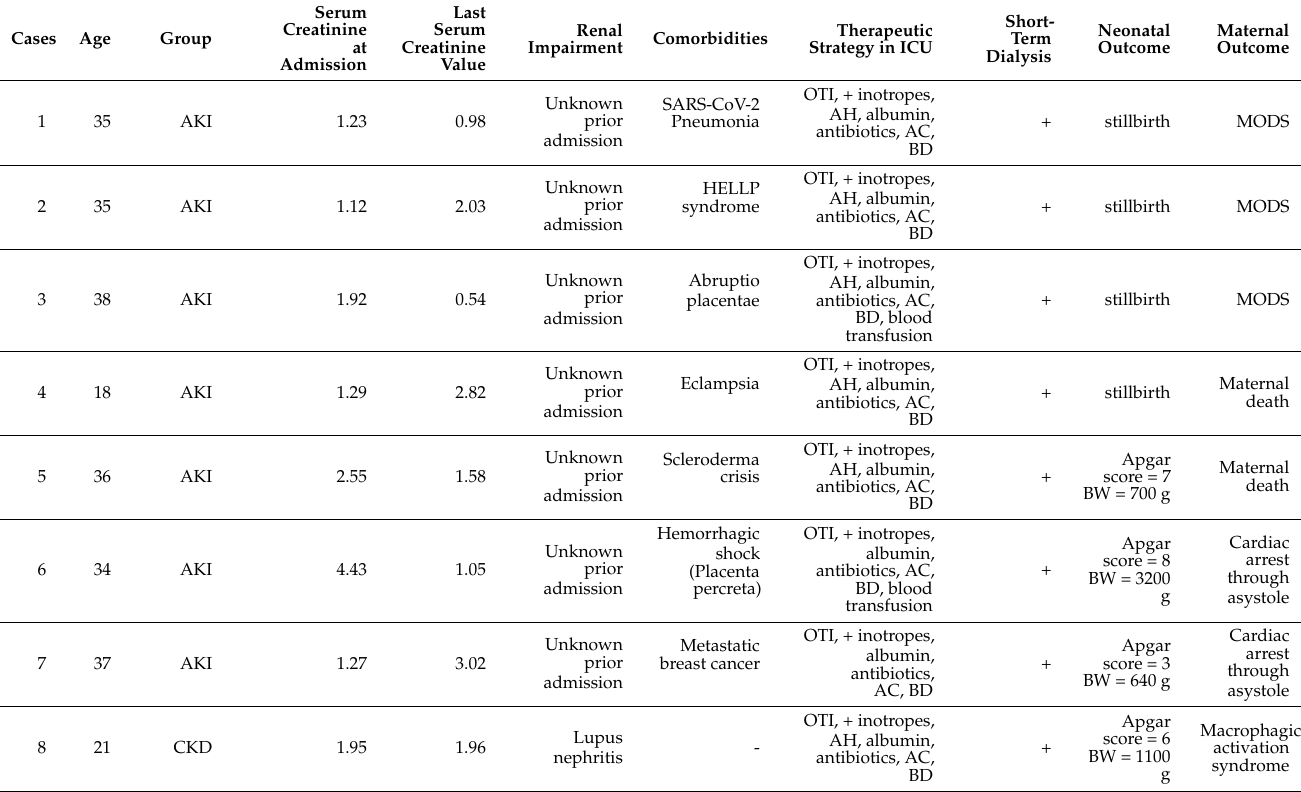
Table 4. Synopsis of maternal deaths among